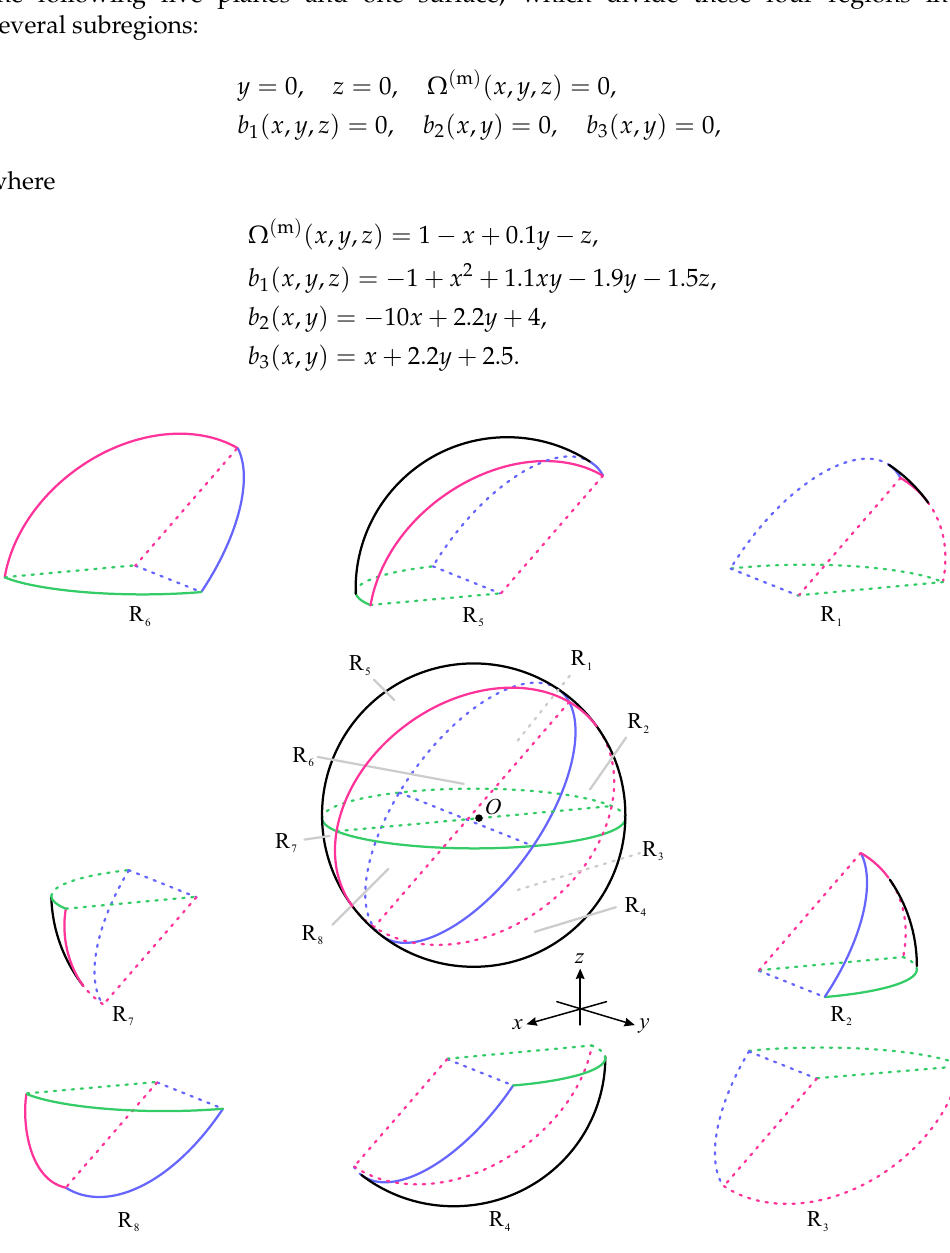
Figure 1. The Poincaré ball is divided into eight regions. The green plane is z = 0, the blue plane is Ω ( m ) = 0, the pink plane is y = 0 and a set of non-isolated equilibrium points fill up the pink circle where the plane y = 0 intersects Poincaré sphere. The point O is the center of the ball. The region R 1 is divided into seven subregions R 1 i ( i = 1, · · · , 7 ) (see Figures 2 and 3). The dynamic behavior of system (19) in these seven subregions is presented in Table 2. For subregion R 11 , its front part is bounded by Ω ( m ) = 0 and y = 0, its back is restricted by the Poincaré sphere, and its bottom is limited in z = 0. As shown in Table 2, the trajectories of system (19) monotonically decrease in the positive y and z axes and increase in the positive x axis, which indicates that the trajectories in R 11 can get to subregions R 12 , R 17 and the sources of these trajectories are subregion R 16 and infinite equilibrium points in y = 0 restricted to R 11